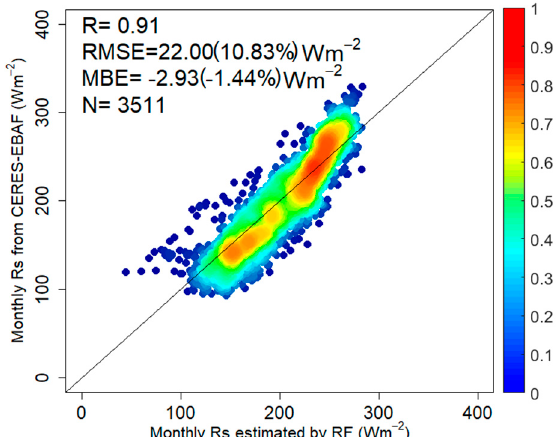
Figure 11. Evaluation results of the estimated monthly mean R S based on the RF method using CERES–EBAF R S data from February to May 2016. N is the number of data points.